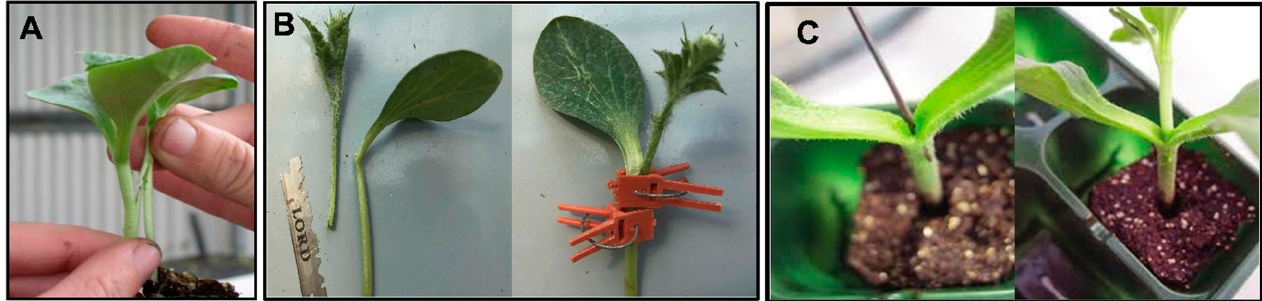
Figure 1. Three grafting methods were used for watermelon grafting, ( A ) tongue grafting method (T), ( B ) splice grafting method (S), and ( C ) hole grafting method (H).